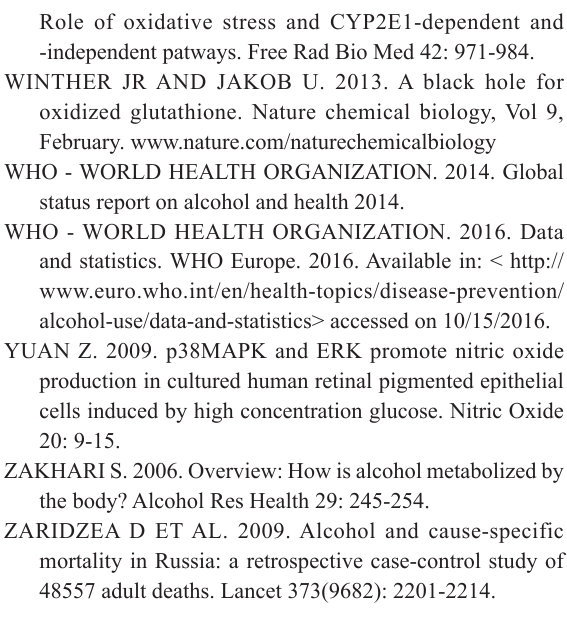
TABLE SI - Precision values of the LC–MS/MS analyses for the standard phenolics